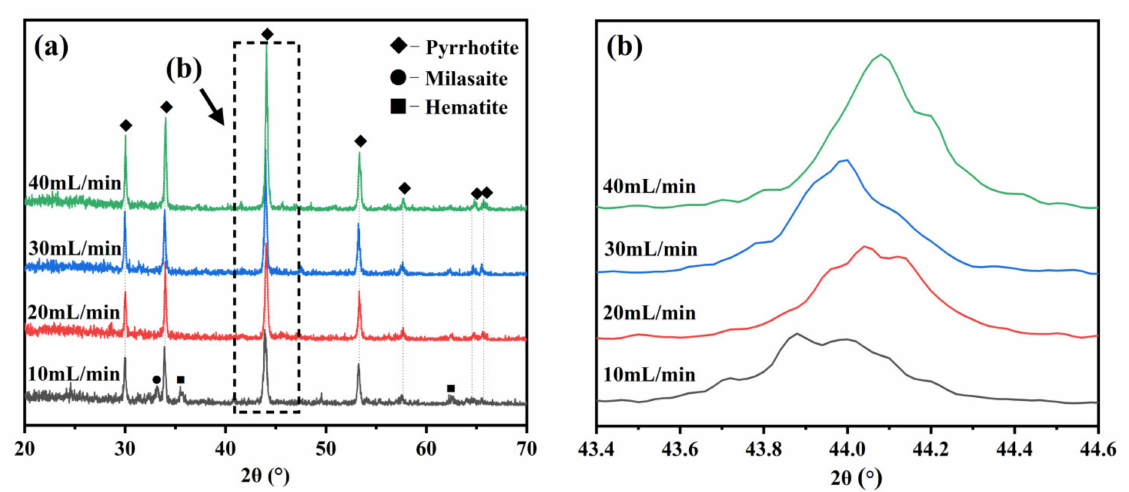
Figure 5. ( a ) XRD patterns of sulfidation products obtained under different gas speeds; ( b ) partially enlarged areas (2 θ : 43.2–44.6 ◦ ) of ( a ) (sulfidation conditions: 575 ◦ C, 1.5 h, 3% H 2 S and 97% N 2 balance gas).